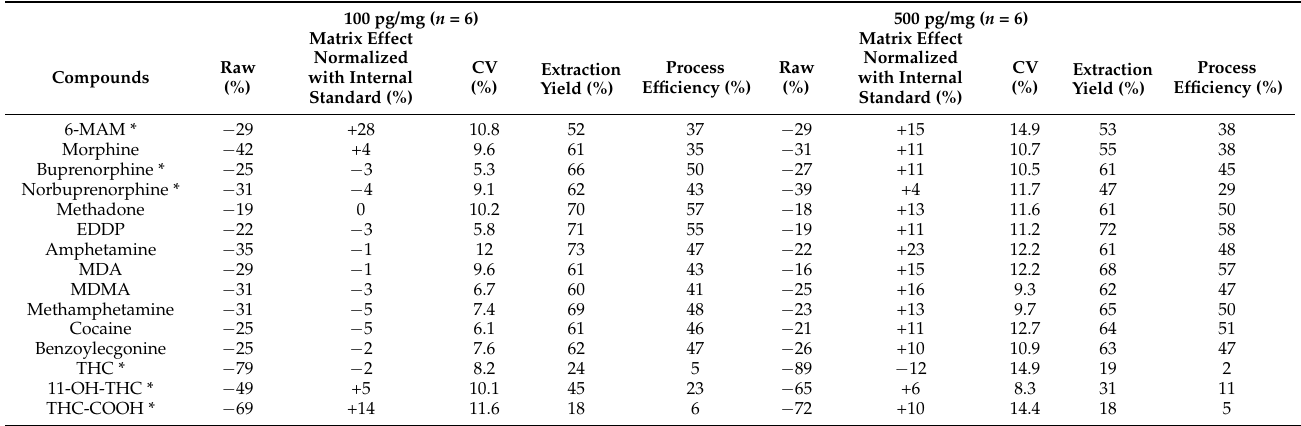
Table 1. Matrix effect and coefficient of variation observed for the 15 compounds at 100 pg/mg and 500 pg/mg (compounds marked with an asterisk (*) were evaluated at 10 pg/mg and 50 pg/mg).